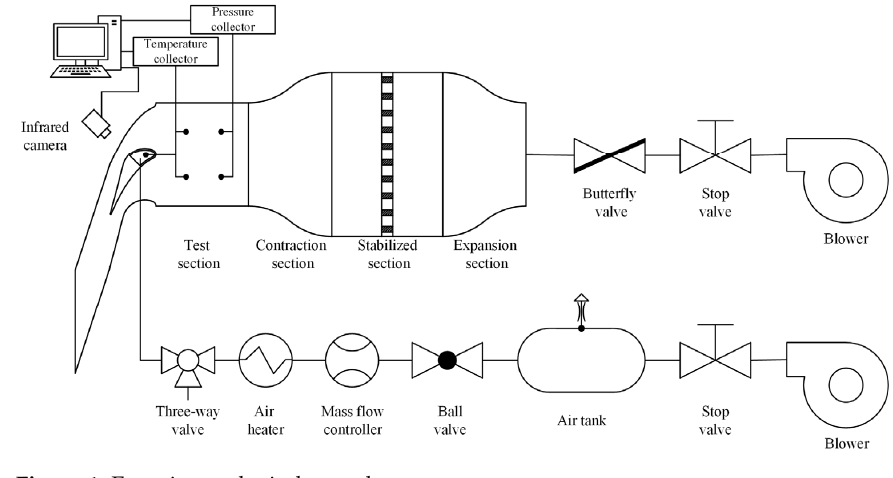
Figure 1. Experimental wind tunnel system.